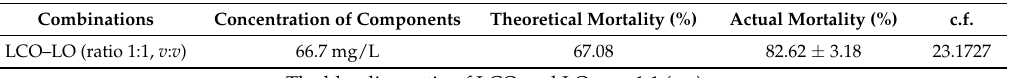
Table 3. Cooperative virulence index (c.f.) of the mixture of Ligusticum chuanxiong oil (LCO) and lemongrass oil (LO) against Aphis citricola van der Goot (24 h). lemongrass oil (LO) against Aphis citricola van der Goot (24 h).